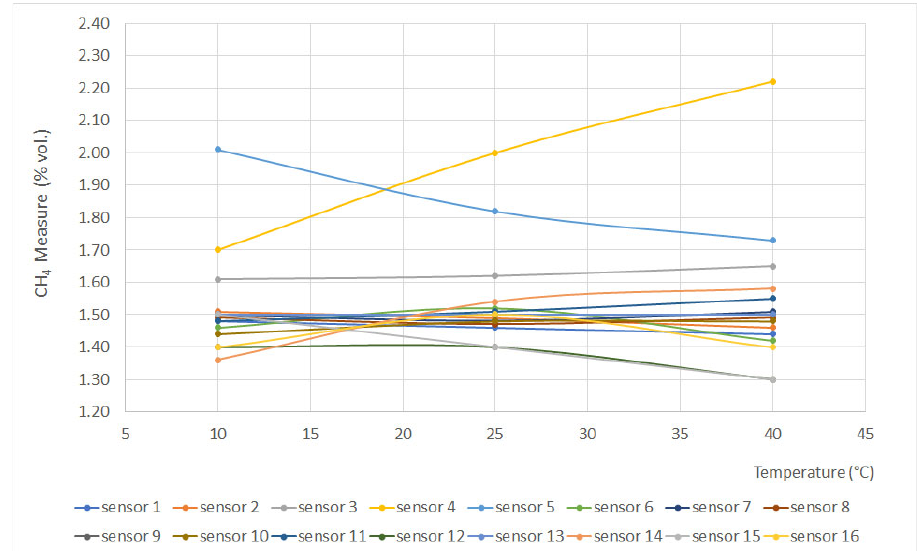
Figure 5. Temperature curves for 1.5% vol.